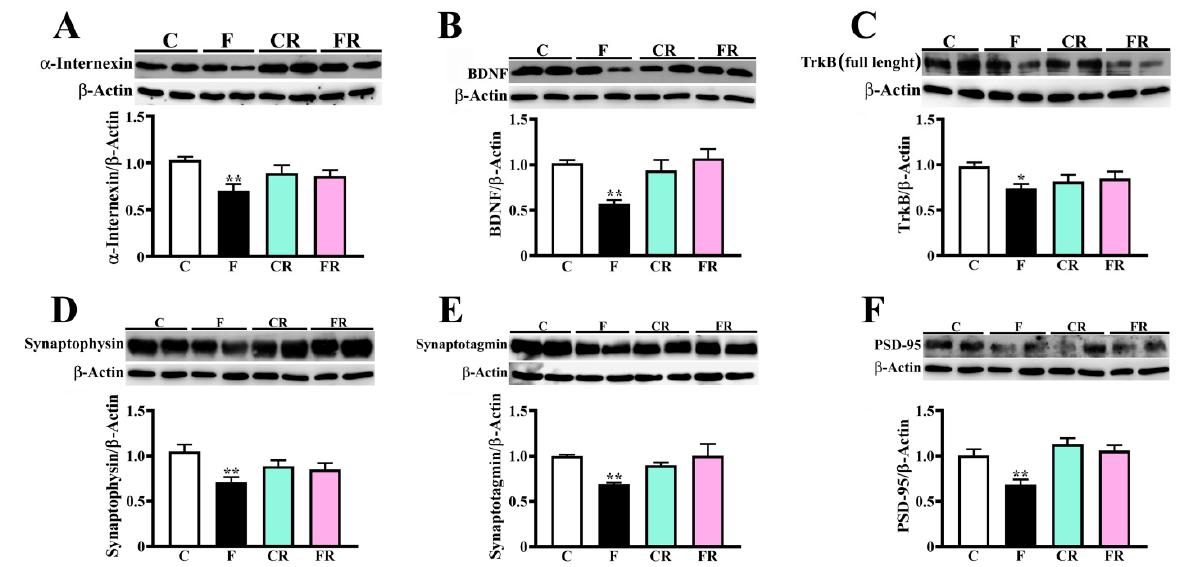
Figure 6. Evaluation of α -internexin, BDNF, TrkB, and synaptic proteins in rat hypothalamus. ( A ) α -internexin, ( B ) BDNF, ( C ) full-length TrkB isoform, ( D ) synaptophysin, ( E ) synaptotagmin, and ( F ) PSD-95 were measured in protein extracts from the hypothalamus of control adolescent (C), fructose-fed adolescent (F), young-adult control rescued (CR), young-adult fructose-rescued (FR) rats. Samples were analyzed by 10% ( α -internexin, TrkB, synaptotagmin, PSD-95) or 12.5% (BDNF, synaptophysin) SDS-PAGE and western blotting. Immunocomplexes were detected by mouse anti- α -internexin and GAM-HRP IgGs ( A ), or rabbit anti-BDNF ( B ), rabbit anti-TrkB ( C ), rabbit anti-synaptophysin ( D ), rabbit anti-synaptotagmin ( E ), rabbit anti-PSD-95 ( F ) and GAR-HRP IgGs. After detection, the membranes were stripped and treated with anti- β -actin. Means ± SEM of eight animals from each experimental group are shown. * p < 0.05, ** p < 0.01 versus C (one-way Anova followed by Bonferroni post-test).